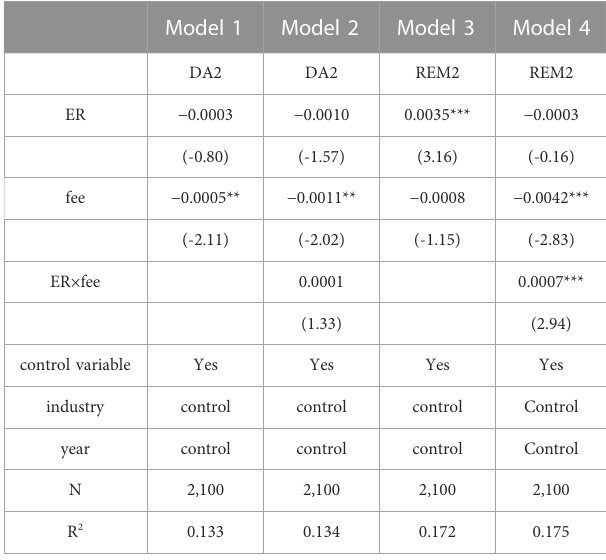
TABLE 5 Robustness